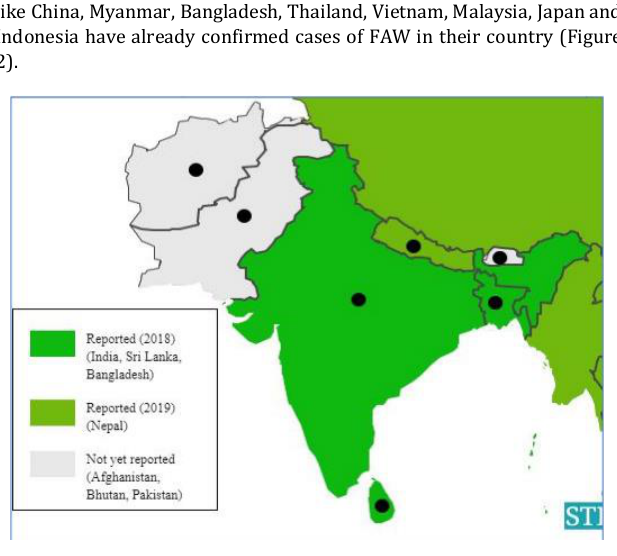
Figure 2: Distribution of FAW in South Asia by Lamsal et al., 2020)